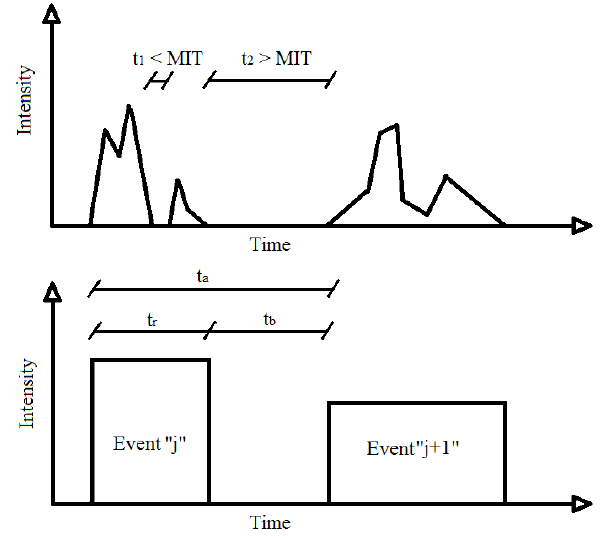
Figure 1. External independent storm properties obtained from the rain gauge